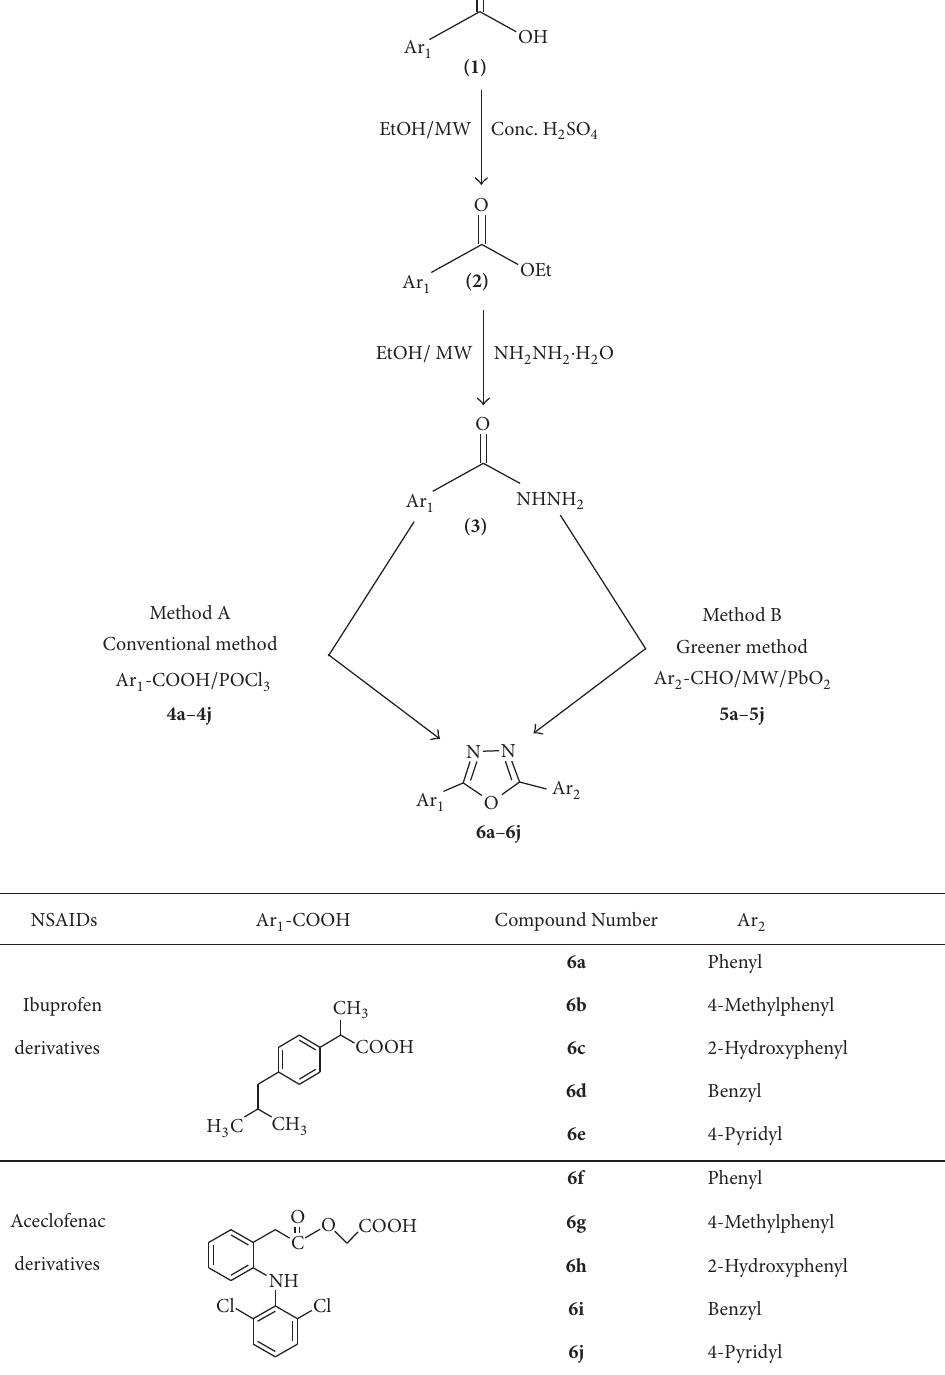
F 1: Scheme of synthesis with various